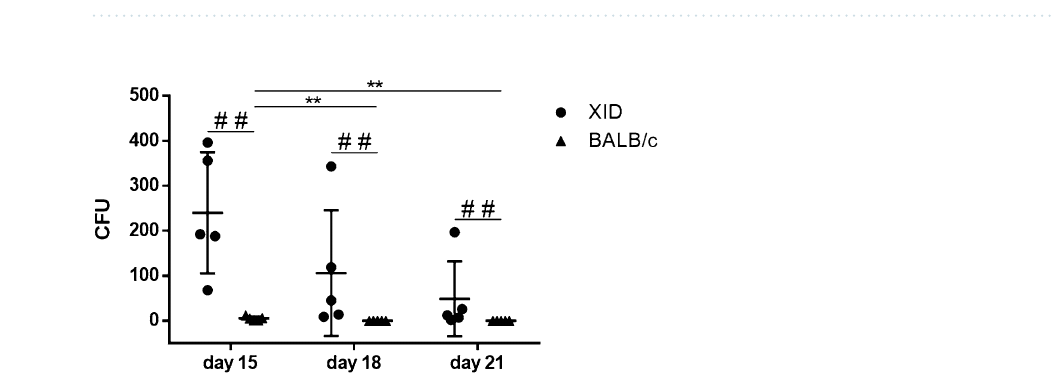
Figure 2. Dosage capsular anti-GXM antibodies from serum samples. ( A ) Immunoenzymatic assay (ELISA) with the serum of animals before infection (0 d) and infected (19 d), for the determination of IgM antibodies reactive against the glucuronoxylomannan polysaccharide (GXM) present in the capsule. ( B ) The same serum was subjected to analysis, by ELISA, for quantification of anti-GXM IgG antibodies. The graphs show the results of 2 independent experiments (n = 5). (**p < 0.01; *p < 0.05) for comparative degree between days 0 and 19 (0 d × 19 d), ( # p < 0.05; ### p < 0.001) comparative degree between strains.